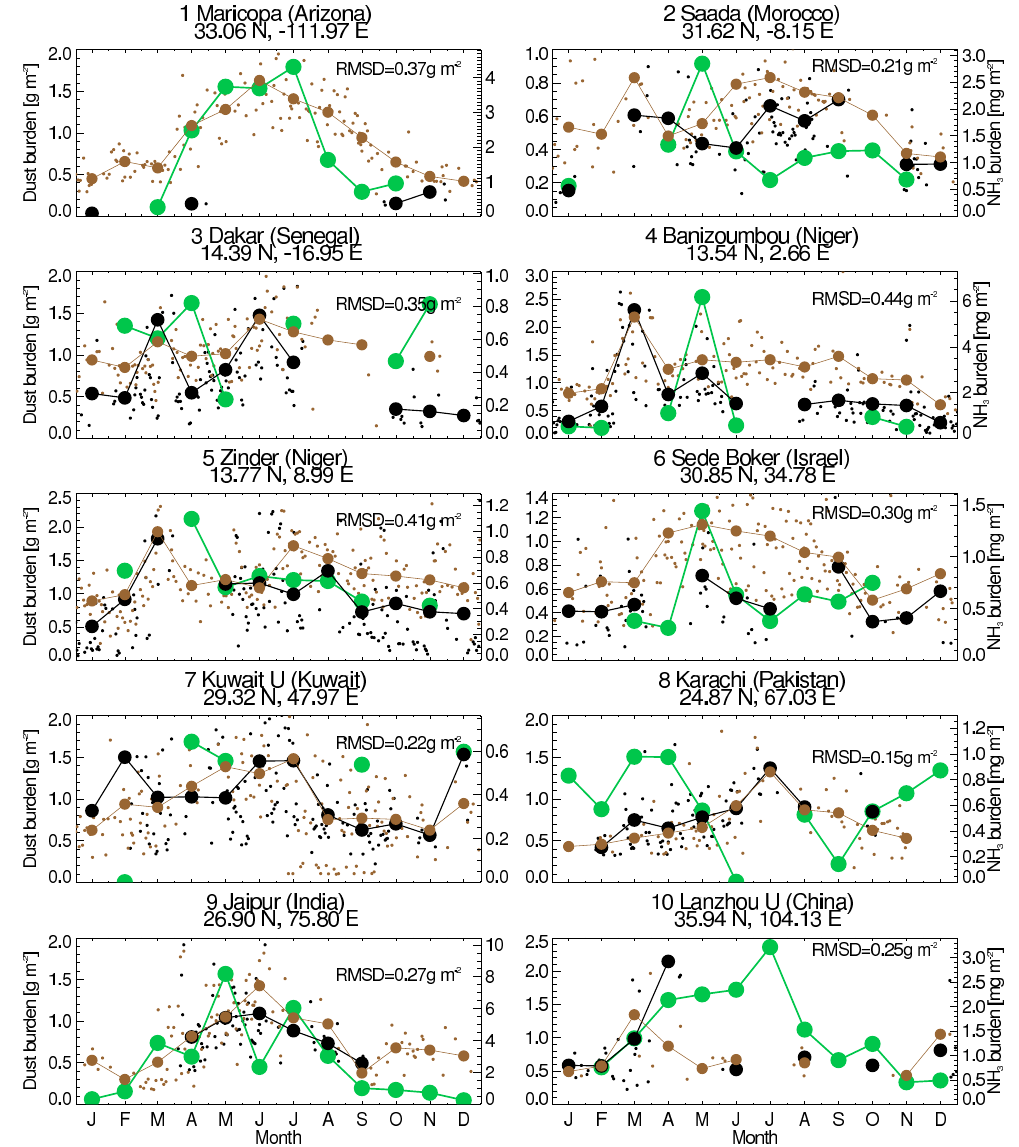
Fig. 4. Daily (small dots) and monthly (large dots) AERONET coarse mode column burden (black), M-DB2 dust burden (brown) in units of gm − 2 (left vertical axes), and IASI NH 3 column burden (green) in units ofmgm − 2 (right vertical axes) at 10 AERONET sites. The root mean square difference (RMSD) in units of gm − 2 between monthly M-DB2 and AERONET mass column burden is provided in the upper